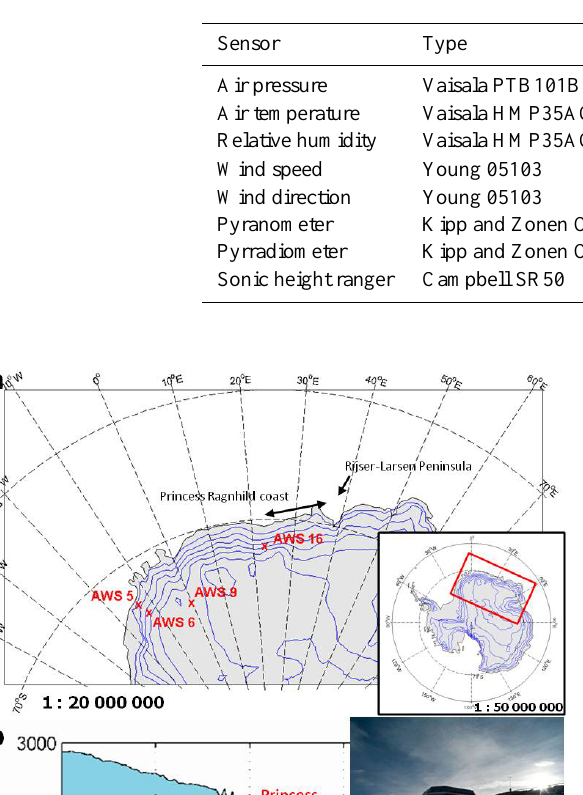
Table 2. AWS sensor specifications (EADT: estimated accuracy of daily totals) (http://ees.kuleuven.be/hydrant/). All four AWSs used in this study are similar in design.